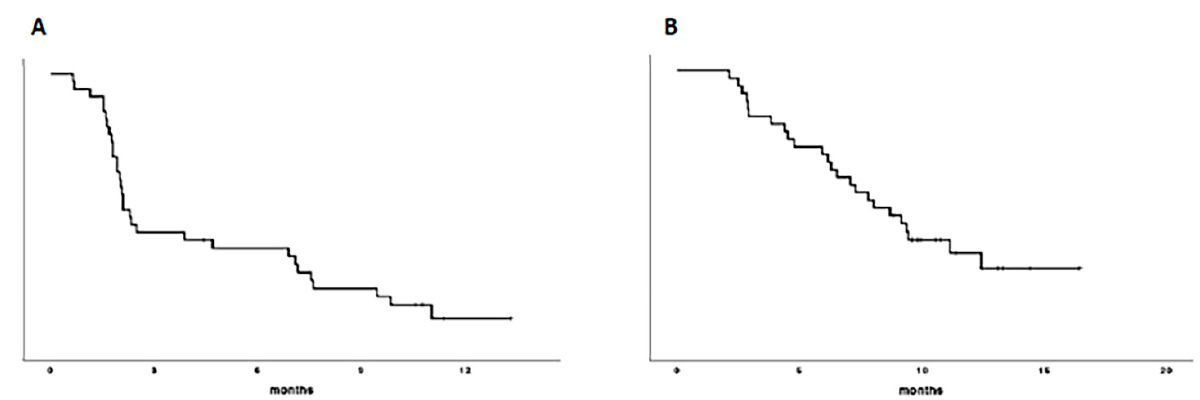
Figure 1. Median PFS ( A ) was 2.1 months (95% CI, 1.7–2.4) and the 6 month-PFS was 38%; median OS ( B ) was 8.04 months (95% CI, 5.3–10.7) and the 12 month-OS was 37%. Table 2. Univariate analysis for PFS and OS. Variables